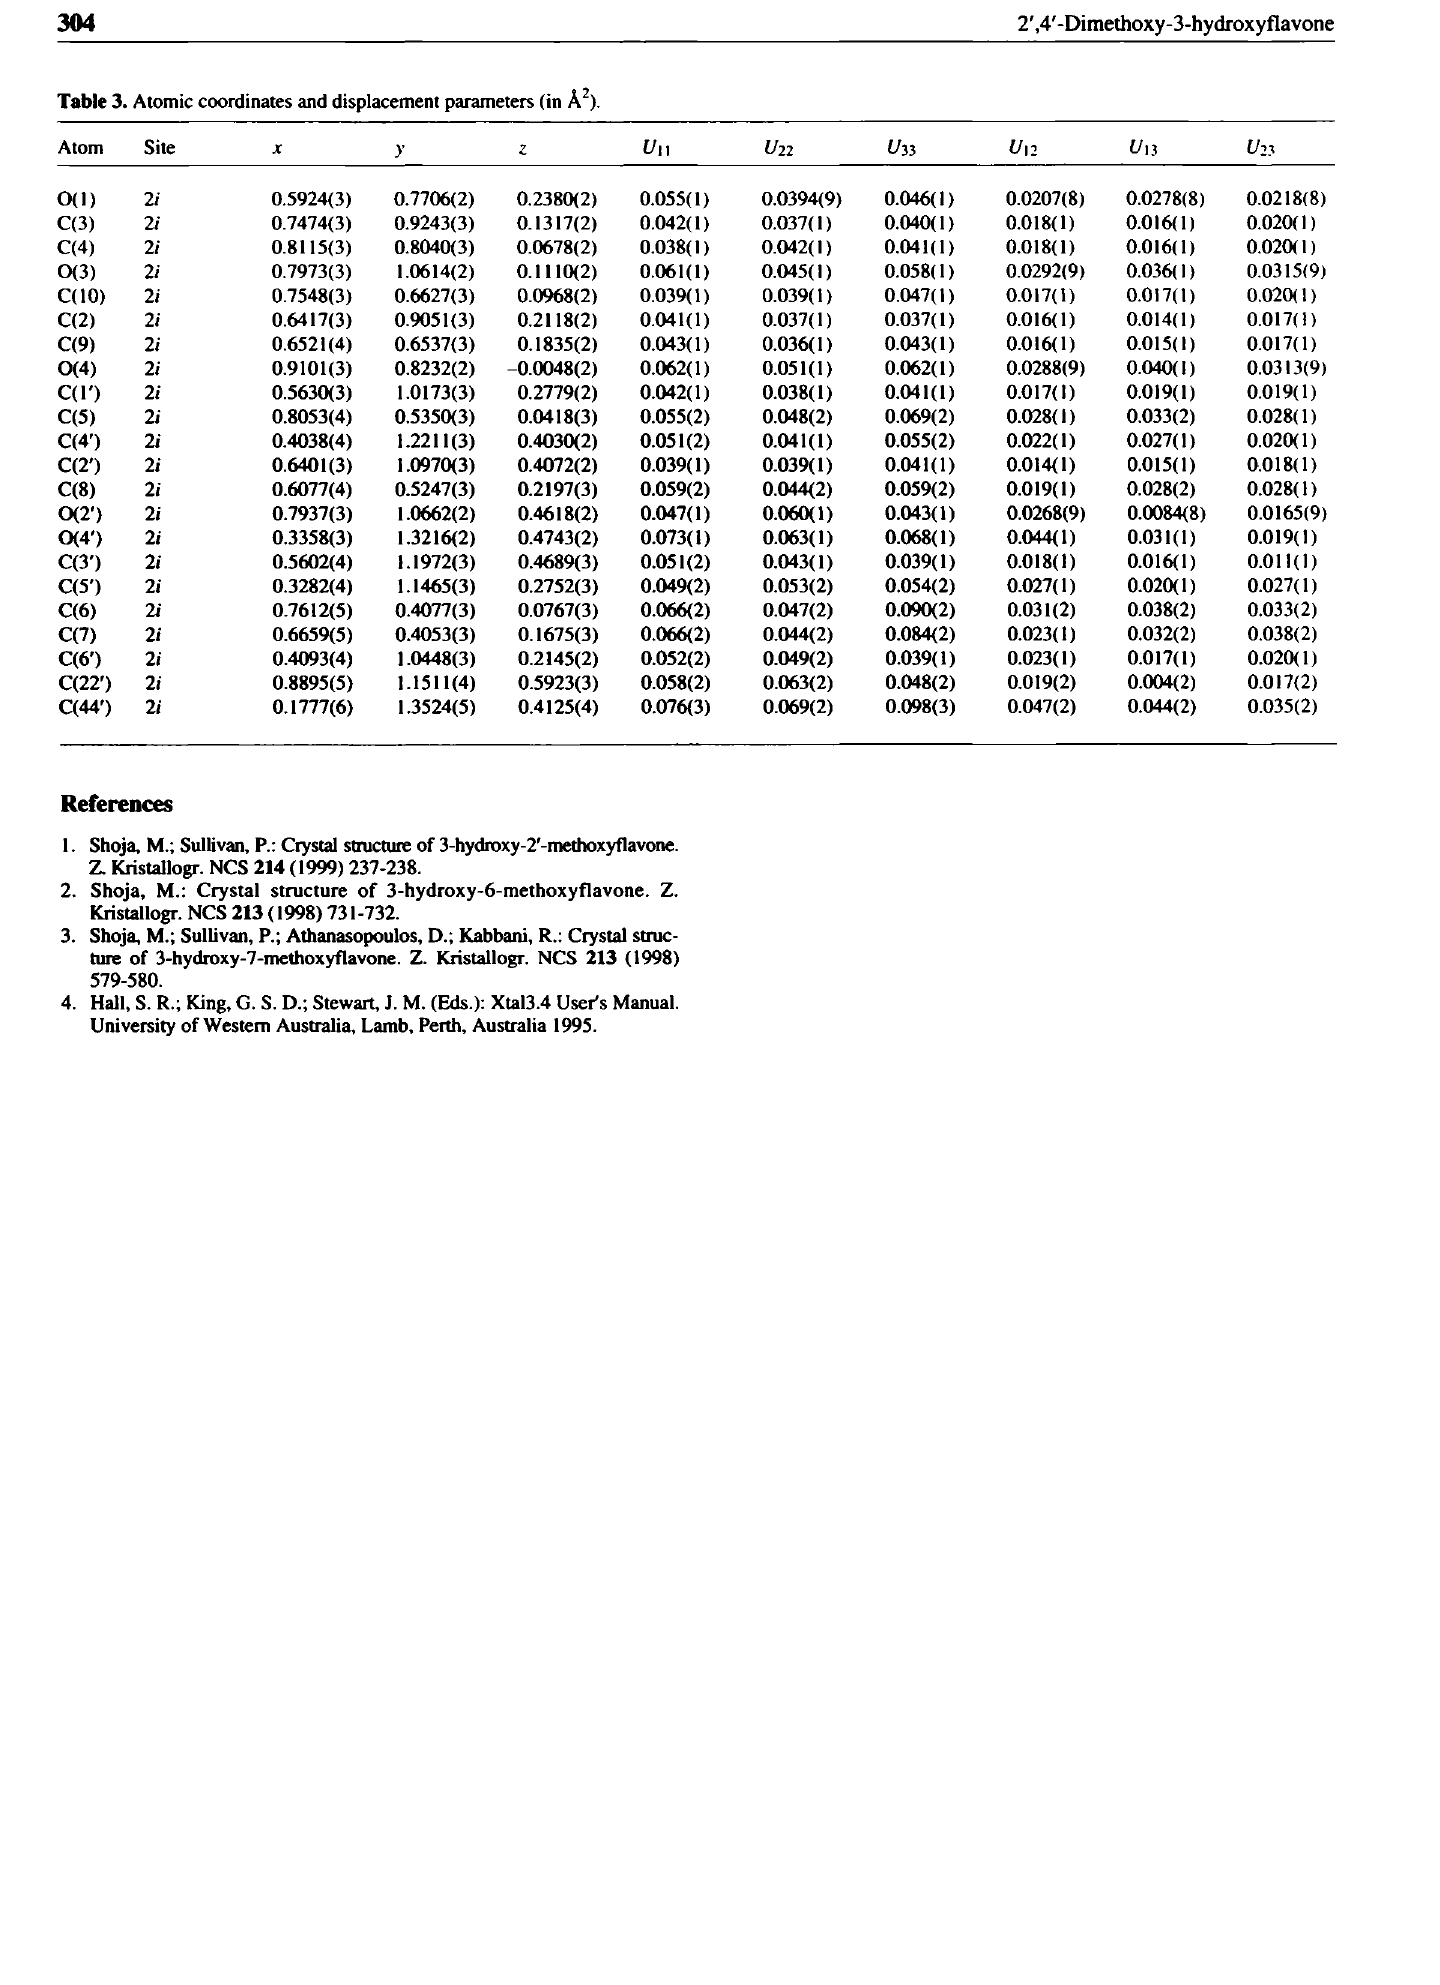
Table 3. Atomic coordinates and displacement parameters (in A 2